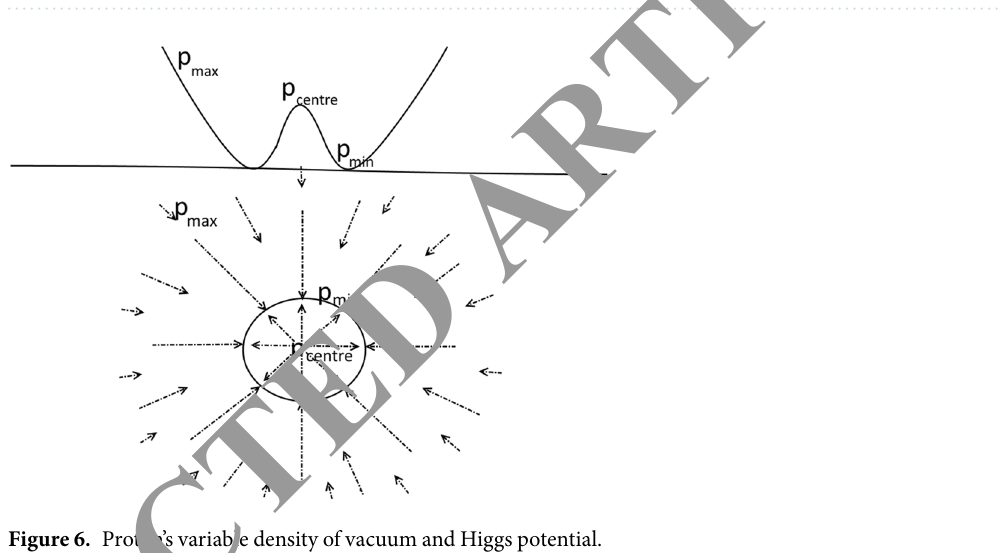
Figure 6. Proton’s variable density of vacuum and Higgs